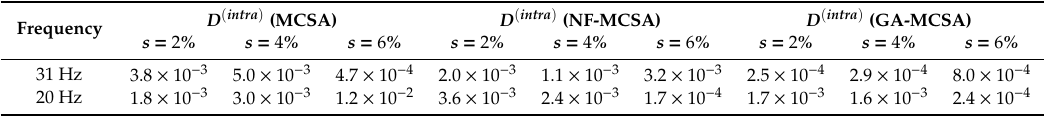
Table 1. Intra-cluster distance for the amplitudes of the